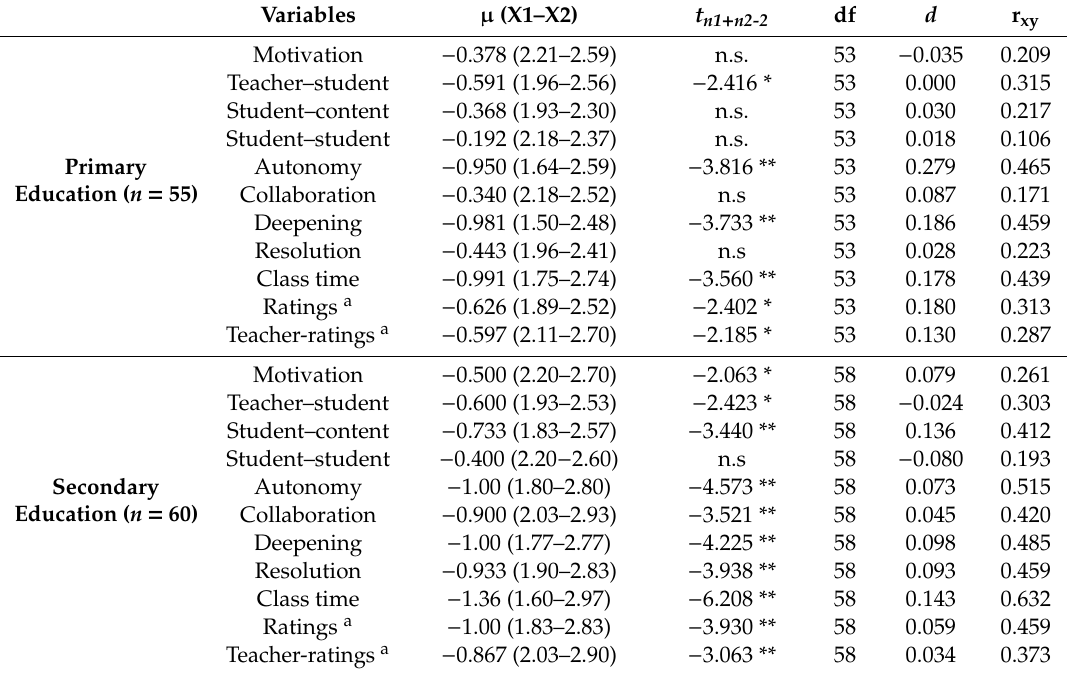
Table 5. Study of the value of independence between CGP 1, CGS 2, EGP 1, EGS 2